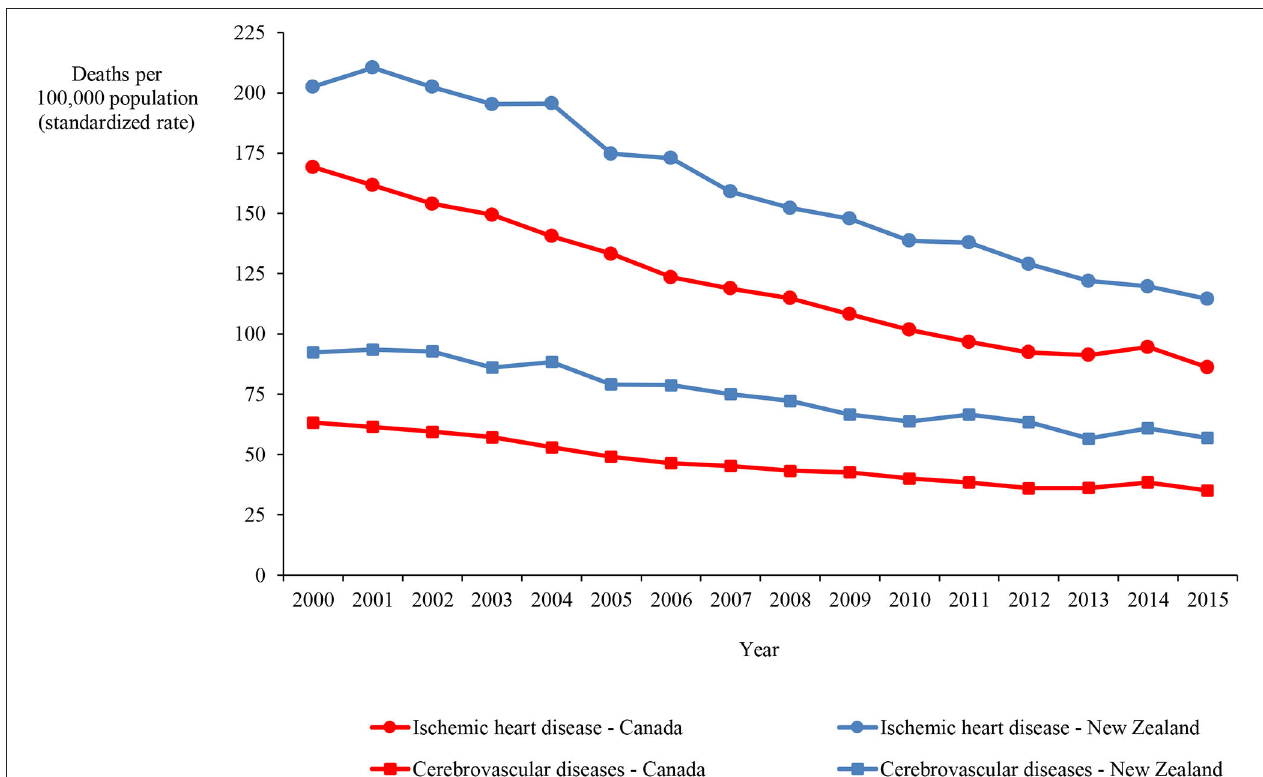
FIGURE 4 | Mortality in Canada and New Zealand for ischemic heart and cerebrovascular diseases,